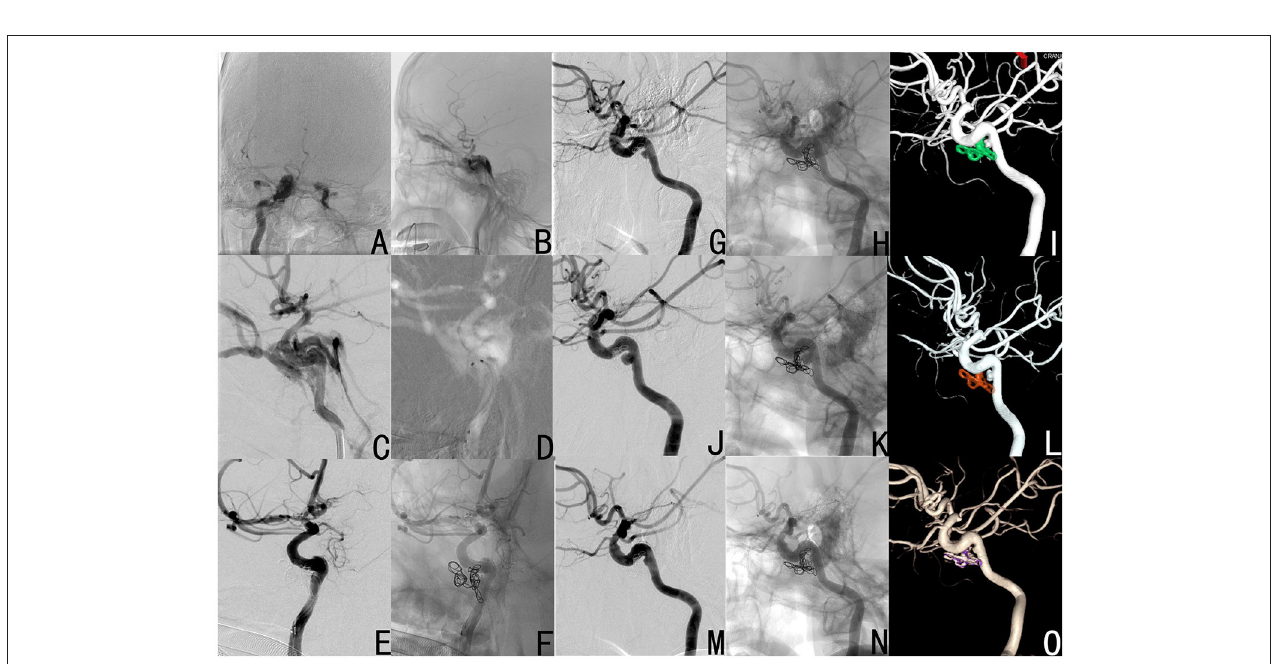
FIGURE 5 | Case 10 was diagnosed with right CCF by DSA ( A : anteroposterior view; B : lateral view), and was treated by simple coil embolization by only using three coils ( C : operation angle for the location of the fistula; D : double microcatheters were put in place; E,F : the occlusion of the fistula). At 3 months (G–I) , 1 year (J–L) and 2 years (M–O) after the operation, the DSA revealed a pseudoaneurysm, which was the result of the compression of coils, but the fistula was always not recanalized. Furthermore, the pseudoaneurysm initially became enlarged, and subsequently